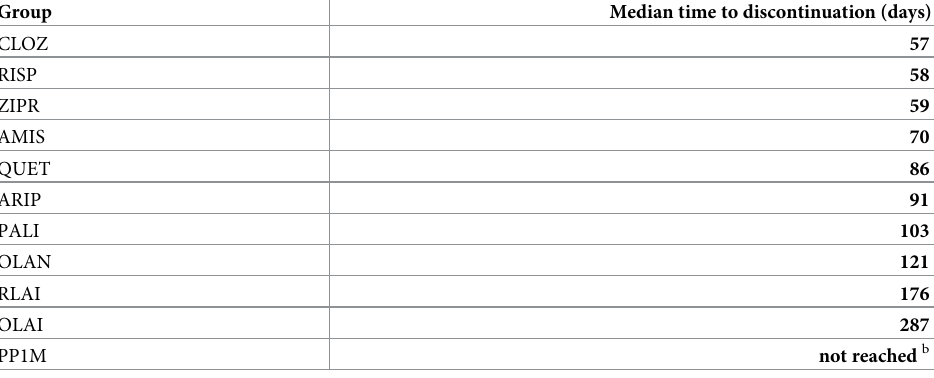
Table 3. Median time of days elapsed to all-cause discontinuation since start of the treatment a .